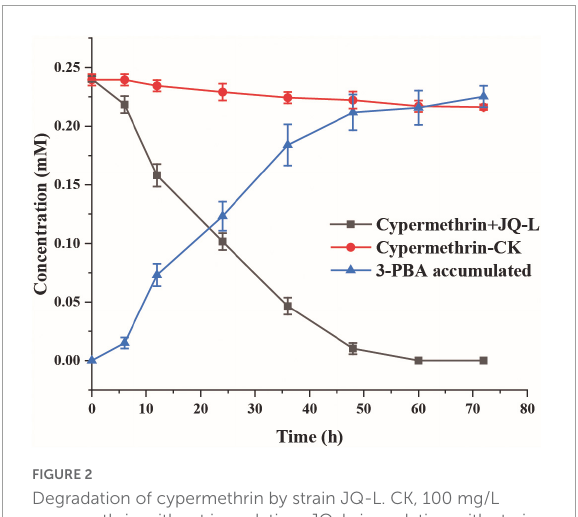
FIGURE2 Degradation of cypermethrin by strain JQ-L. CK, 100 mg/L cypermethrin without inoculation; JQ-L, inoculation with strain